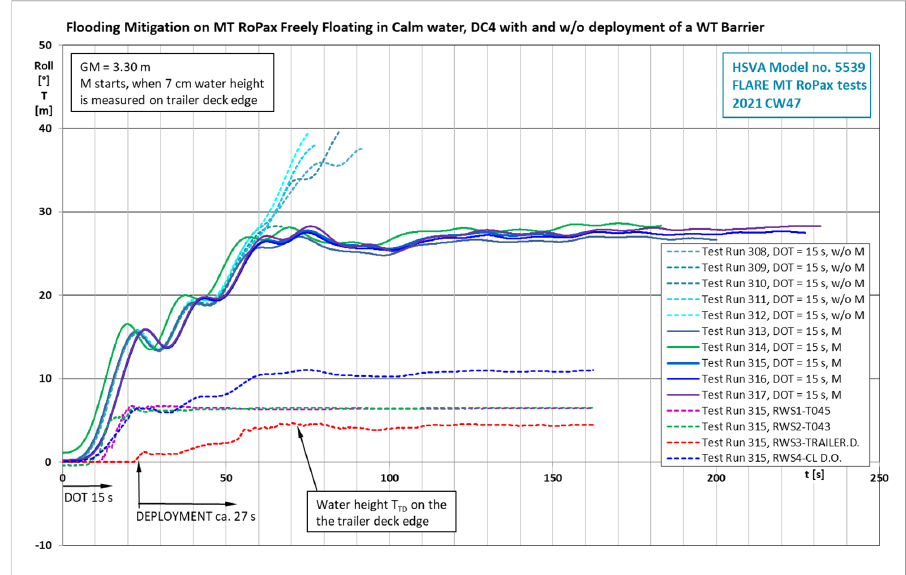
Figure 19. Damage Case 4 with damage opening time 15 s: Roll angle as a function of time with (solid lines) and without (dashed lines) deployment of a watertight barrier on the trailer deck. The dashed curves below show the water height in the damaged compartments, on the trailer deck, and just outside the damage opening for Test Run 315. Water height T TRD of 7 cm on the trailer deck starts the deployment of the WT barrier (RSW = relative wave sensor).